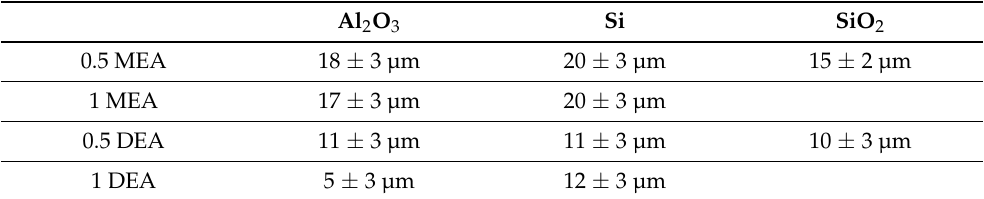
Table 2. The thickness of samples and their standard deviation estimated from confocal micrographs from ZnO layers grown on specific substrates. Thickness was measured in 10 places and averaged.